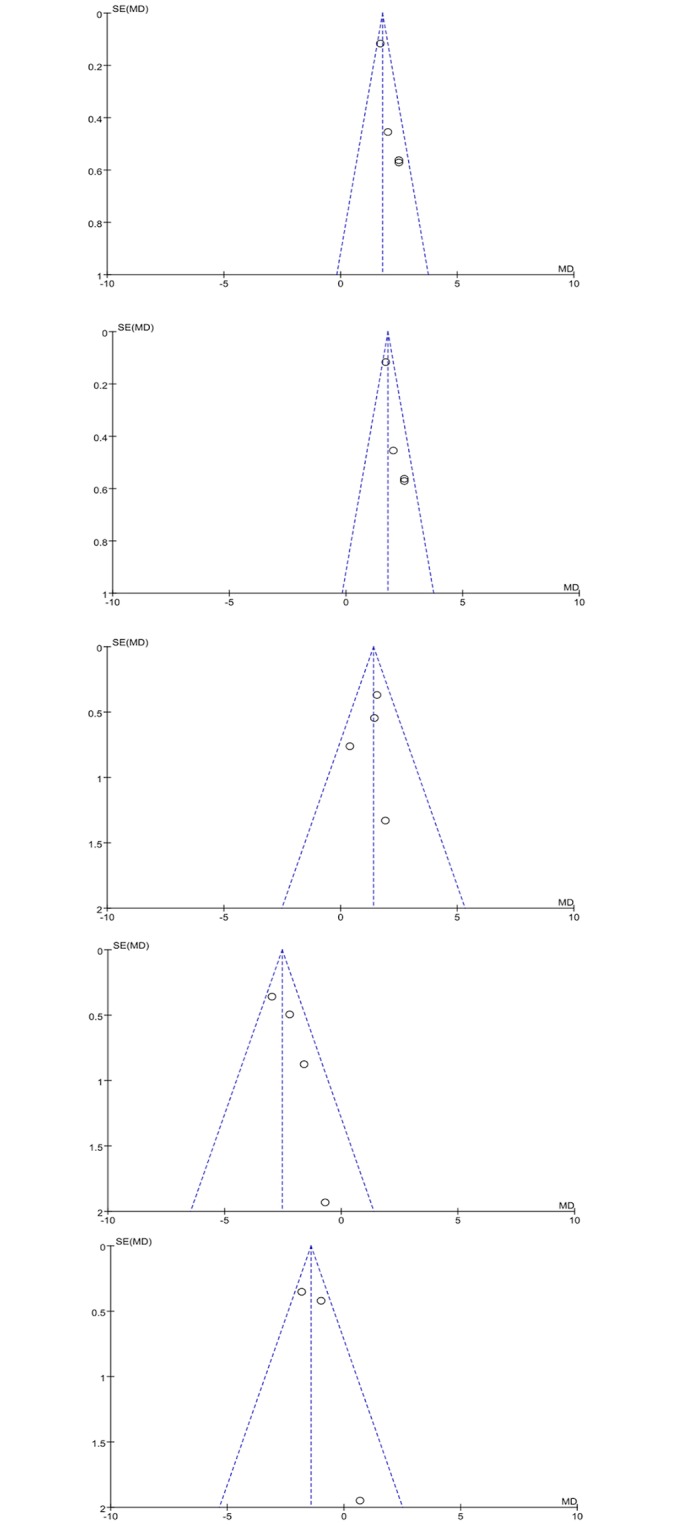
Graphical funnel plots of the included studies.These symmetrical plots indicate the absence of publication bias in the present meta-analysis.